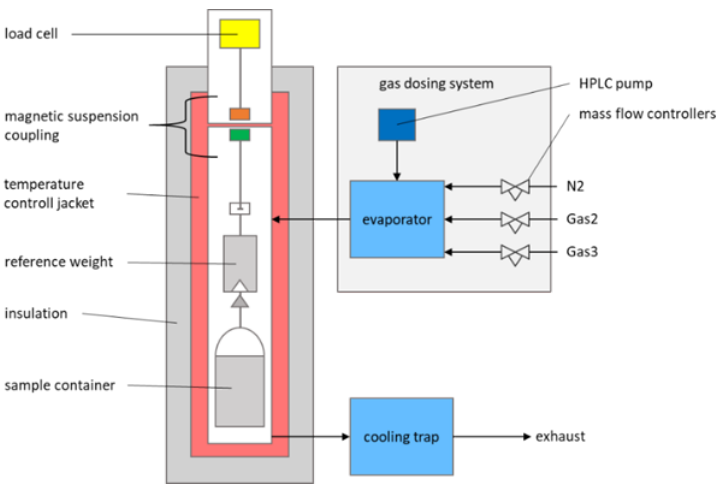
Figure 6. Gravimetric sorption analysis system, Rubotherm IsoSORP series.